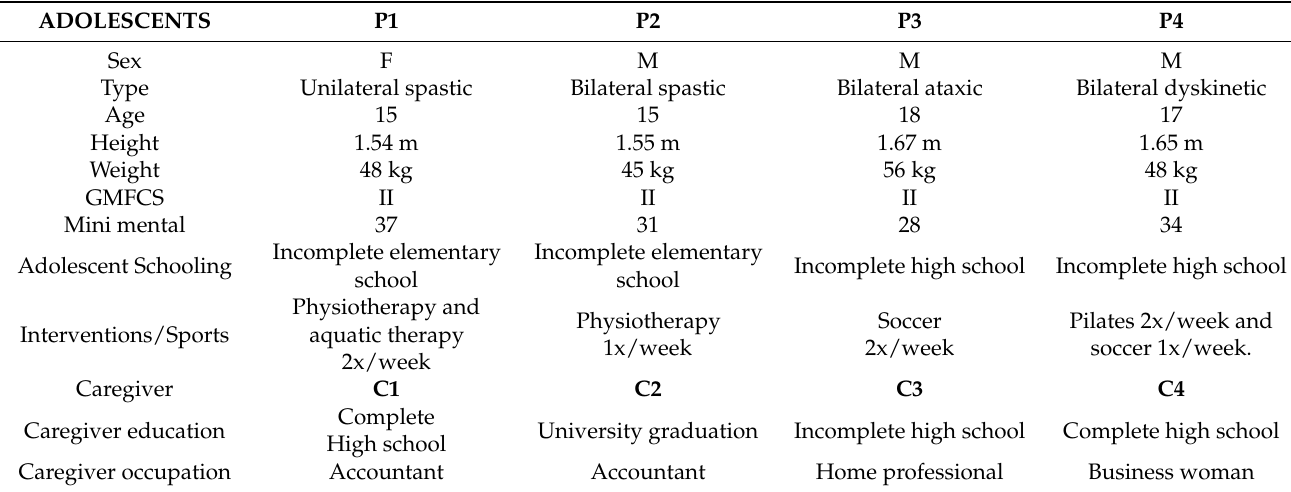
Table 1. Descriptive information on the participants and caregivers of the